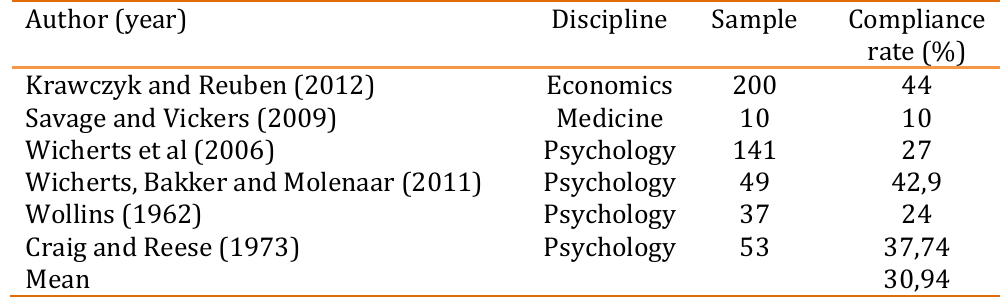
Table 04. Data sharing across